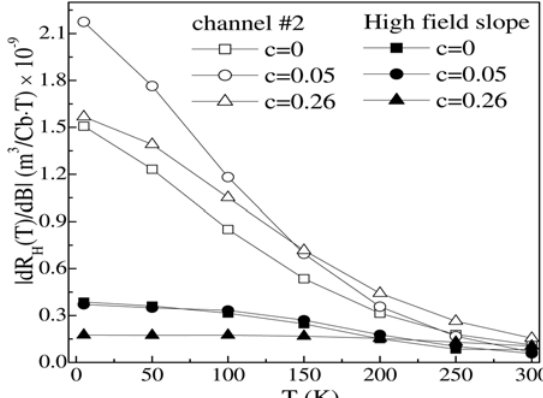
Fig. 2. Absolute values of Hall coefficient, dR H /dB, slopes as a function of temperature.